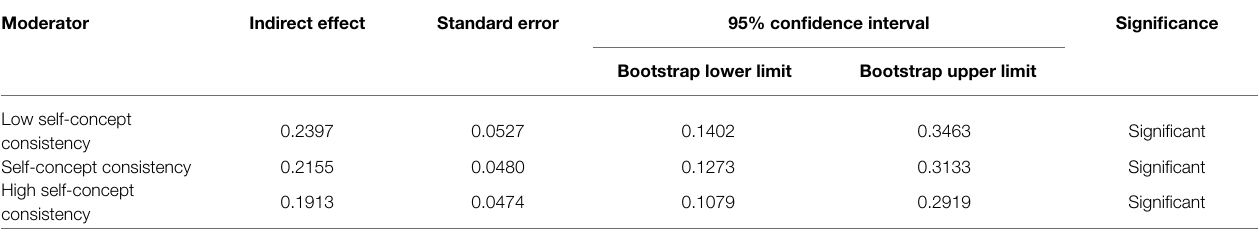
TABLE 5 | Bootstrap analysis of significance test on moderation–mediation